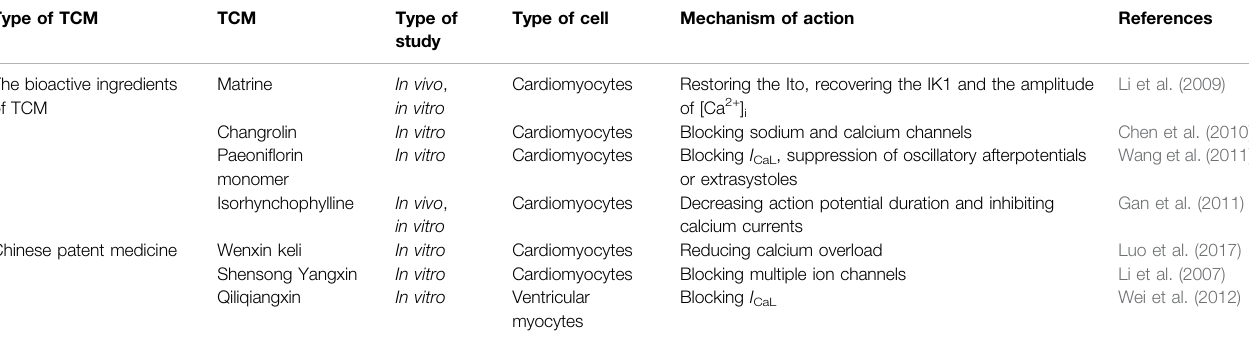
TABLE 2 | The mechanism of TCM in the treatment of arrhythmia through calcium